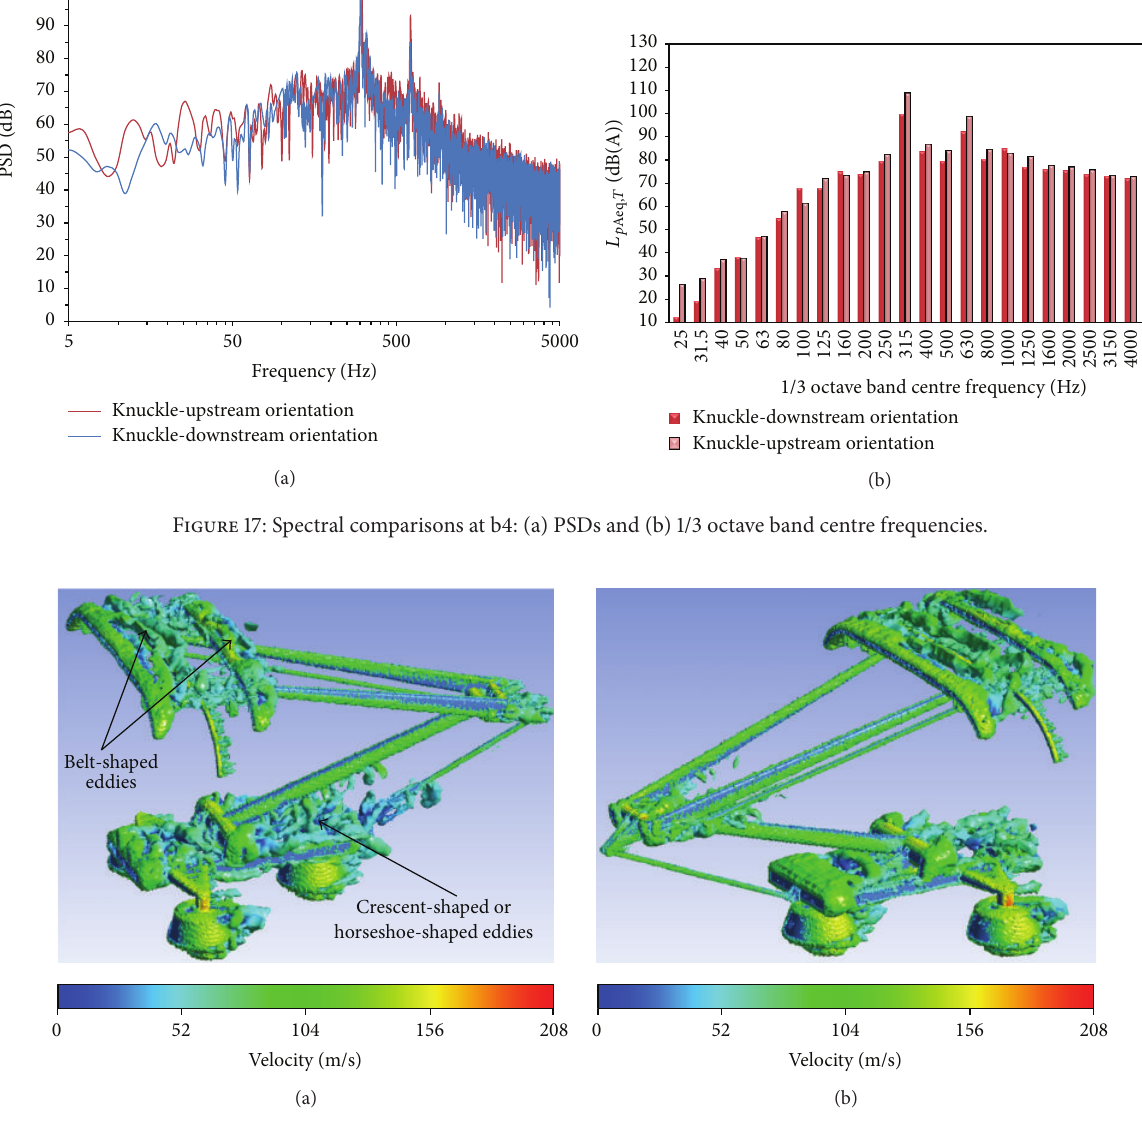
Figure 18: Isosurfaces of the instantaneous normalized Q-criterion: (a) the knuckle-downstream orientation and (b) the knuckle-upstream